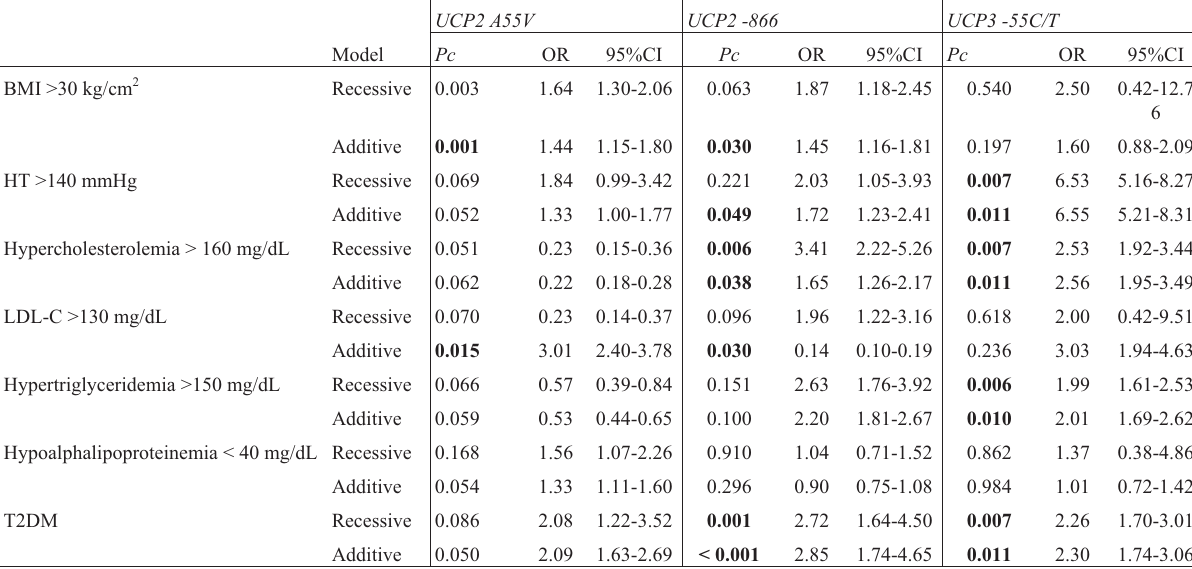
All associations were tested using logistic regression adjusting for age, gender, smoking habits and physical activity. BMI: body mass index, HT: hyper- tension; LDL-C: Low density lipoprotein-cholesterol; T2DM: Type 2 diabetes mellitus. Bonferroni correction was made multiplying by 7 comparisons (Pc). Significant p values are in